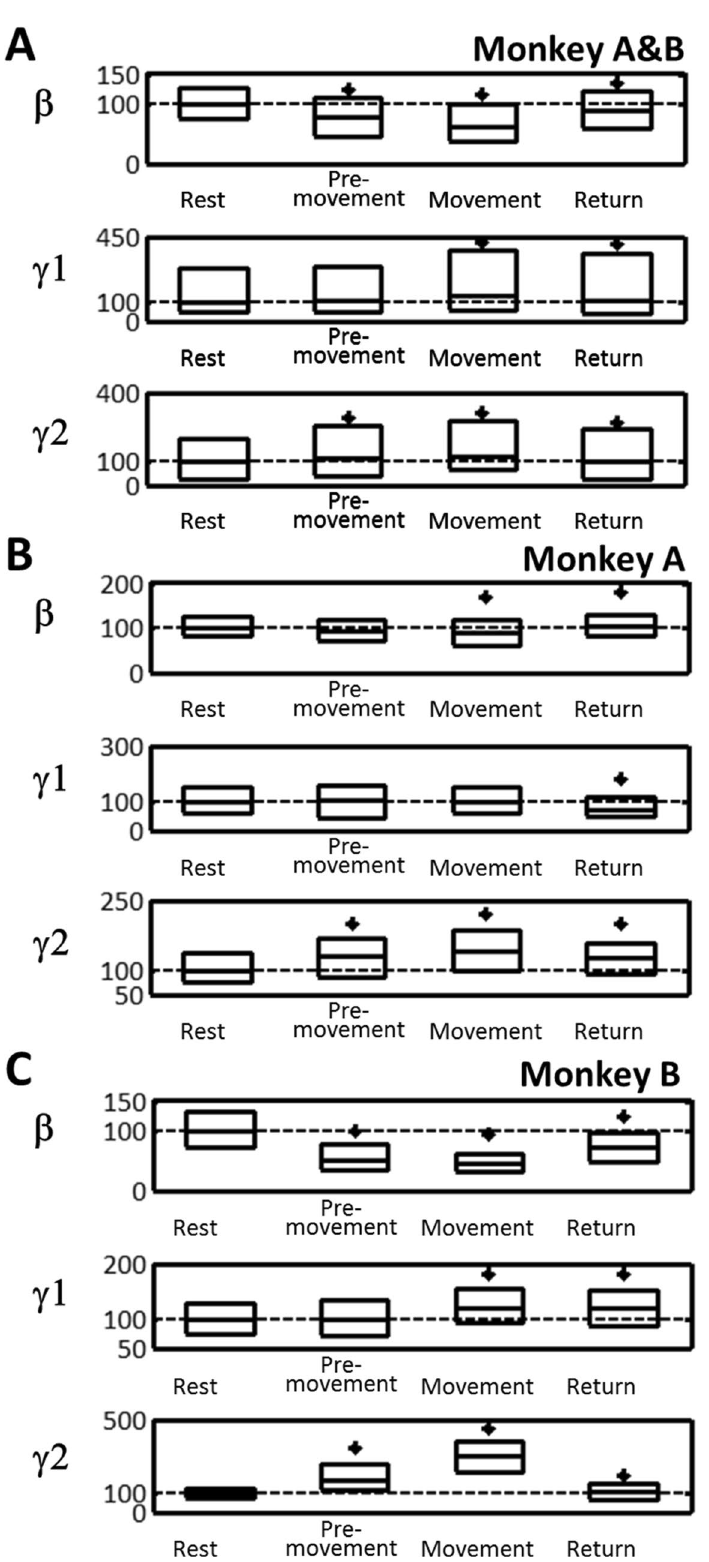
Figure 5. Power spectrum density in β, γ1, and γ2 bands during motor task periods (Rest, Premovement, Movement, and Return) with DBS-OFF. ( A ) Monkeys A and B combined. ( B ) Monkey A. ( C ) Monkey B. Data are expressed as percents of the median during the Rest period. Box plots indicate median and interquartile range (25th-75th percentiles). * P < 0.05, significantly different from